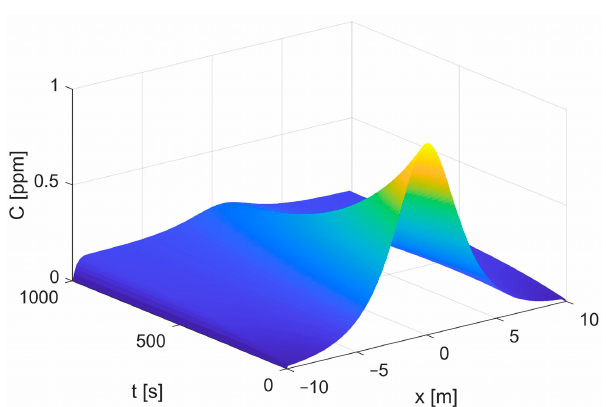
Figure 1. Concentration distribution (standard ADR model).